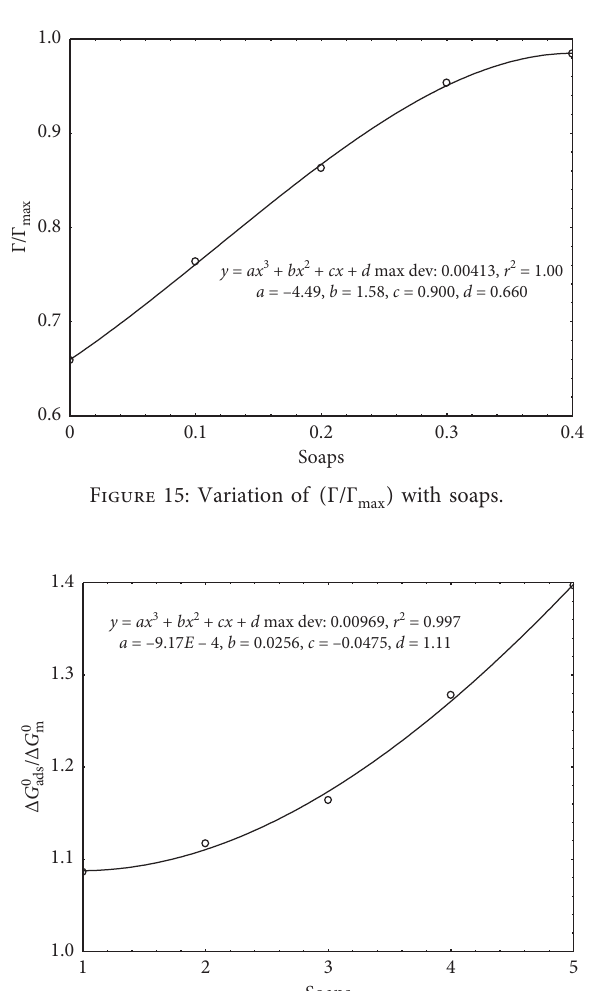
/ Δ G o m ) with soaps. ads